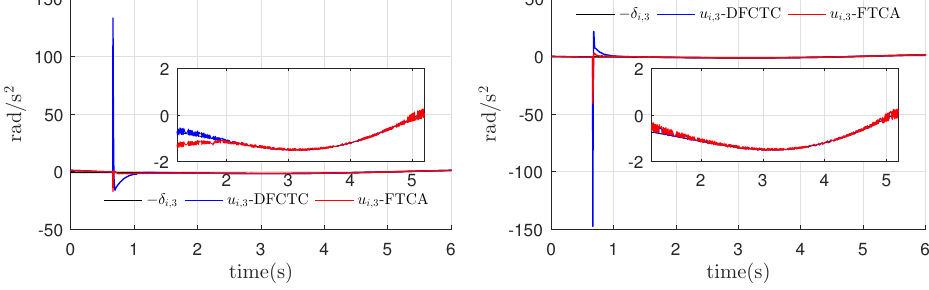
( f ) control signal u i ,3 and the disturbance − δ i ,3 for i = 3